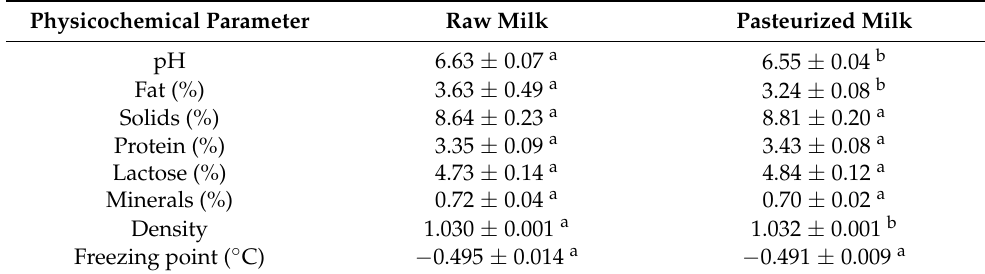
Table 1. Physicochemical composition of milk.